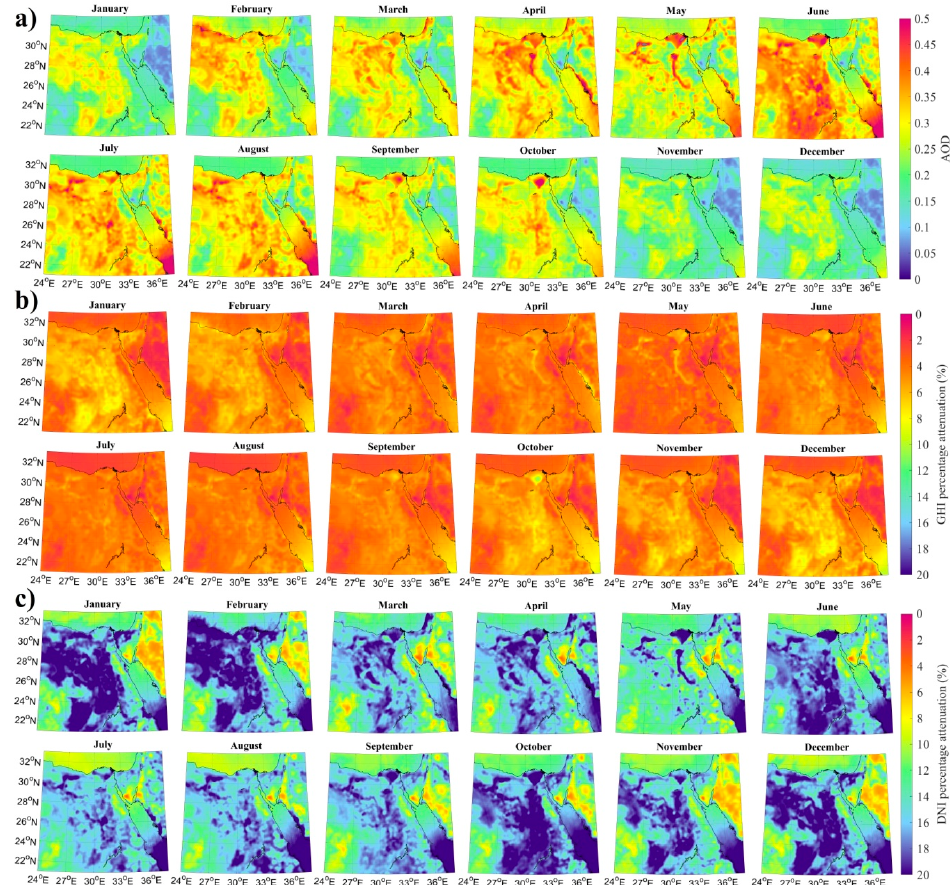
Figure 4. Monthly averages of ( a ) AOD at 550 nm in Egypt using the DT and DB Combined Level 2 product of MODIS for the period 2002–2017, ( b ) GHI and ( c ) DNI solar energy percentage attenuations relative to the aerosol-free simulations under MODIS-based AODs.